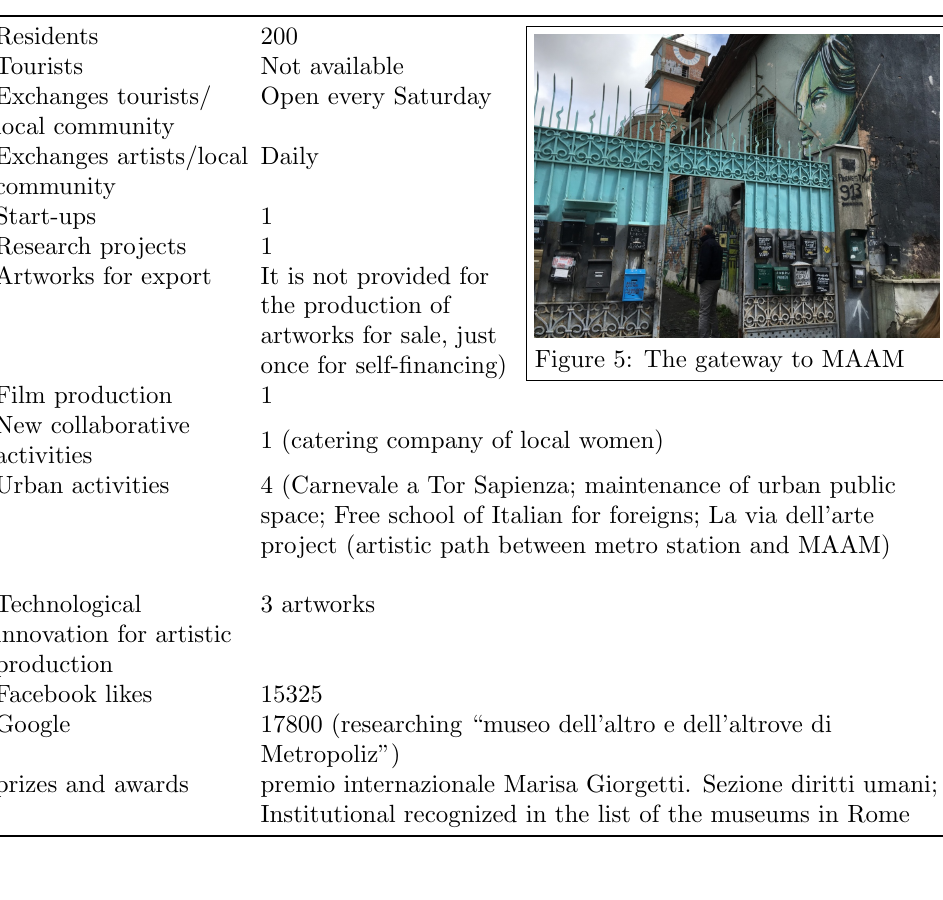
Table 4: Relationships between landscape and external environment